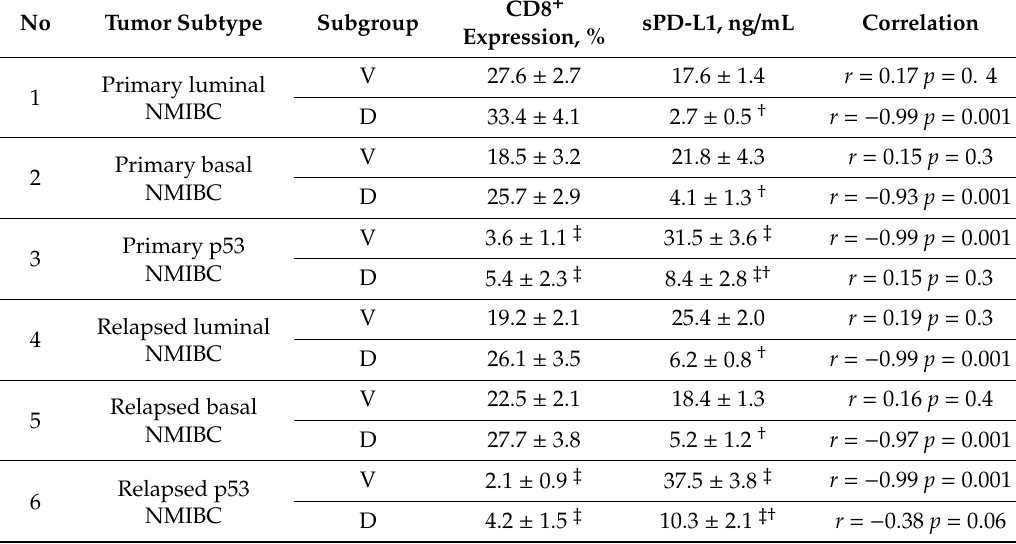
Figure 3. CD8 + population of T cells in PDX’s tumor specimens of mice utilized anti-PD-L1 specific treatment. IHC staining, × 600. Table 3. CD8 + expression in tumor specimens and serum sPD-L1 level in mice, non-muscular invasive bladder cancer (NMIBC) PDXs carriers, depending on specific pharmacological intervention utilized ( n = 10 in each